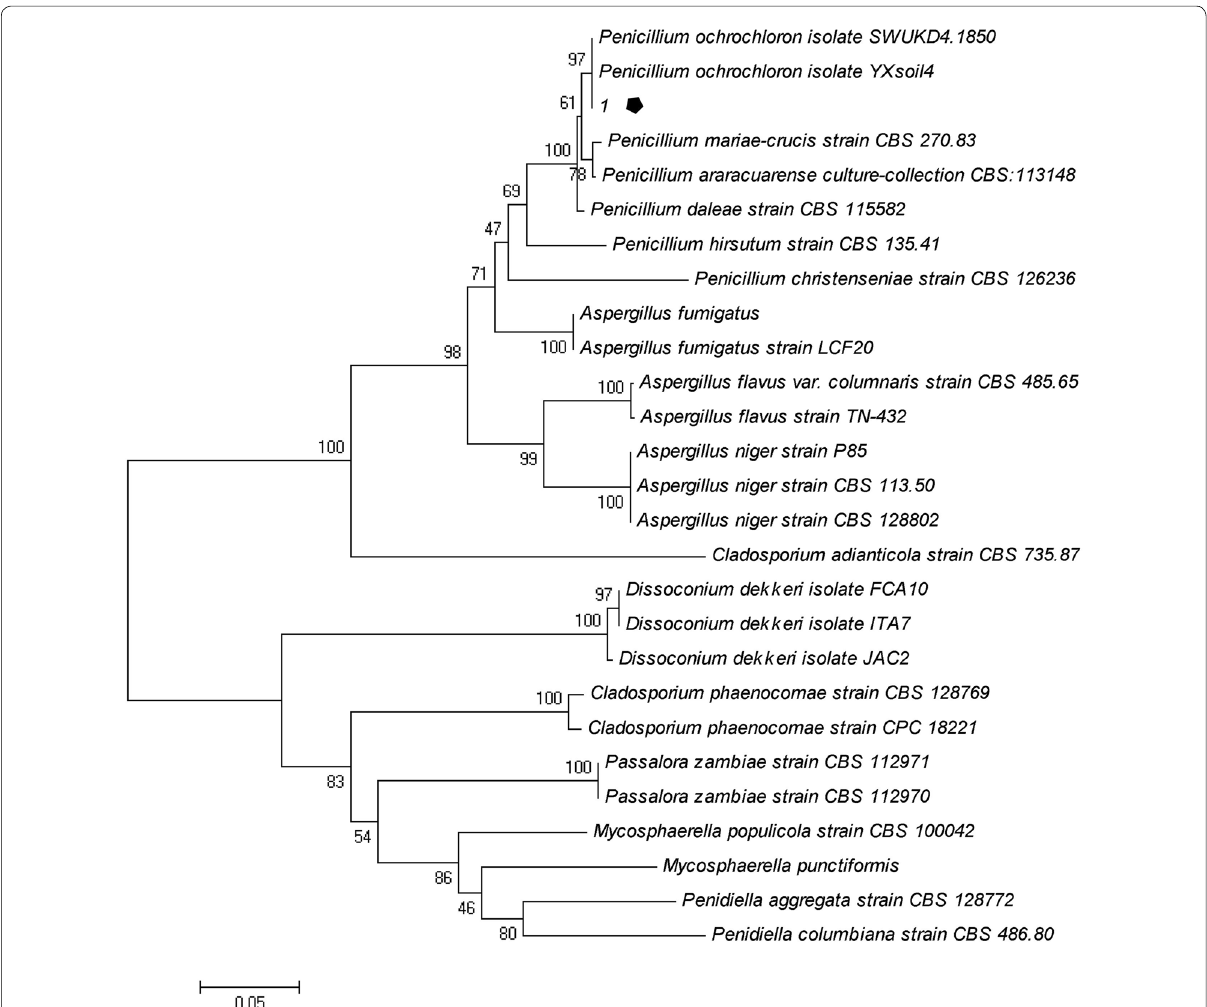
Fig. 2 Phylogenetic tree inferred from the 5.8S-ITS1/ITS4 rRNA gene sequences of Penicillium and